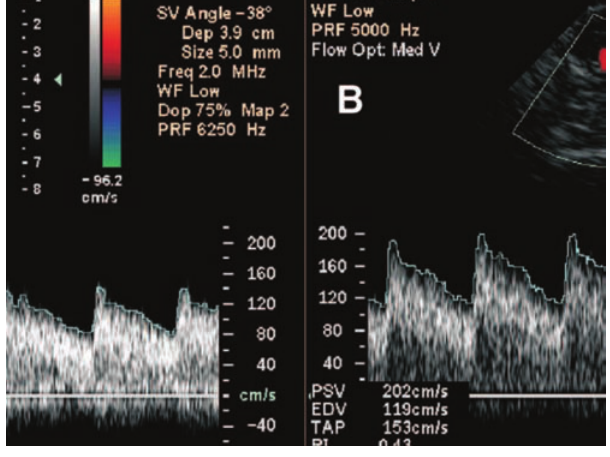
Figure 2. Transcranial doppler ultrasonography. Normal blood velocity at left side, and increased blood velocity at right